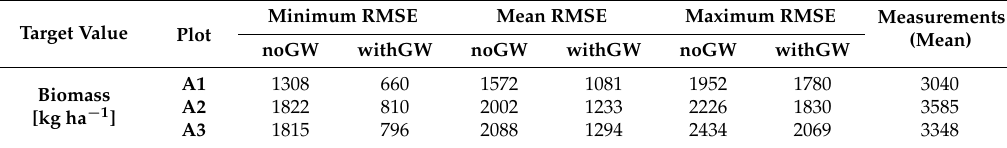
Figure 4. Measured data and simulated confidence intervals for the harvested biomass for the plots A1, A2 and A3 (from top). Confidence intervals for noGW simulations are shaded in light blue, withGW simulations are in light green and overlap between noGW and withGW in darker blue-green. Black triangles depict the spring harvests, black squares depict the late summer harvests. Additional information can be found in Tables A3 and A4. Table 3. RMSE for behavioural simulation runs of harvested biomass.